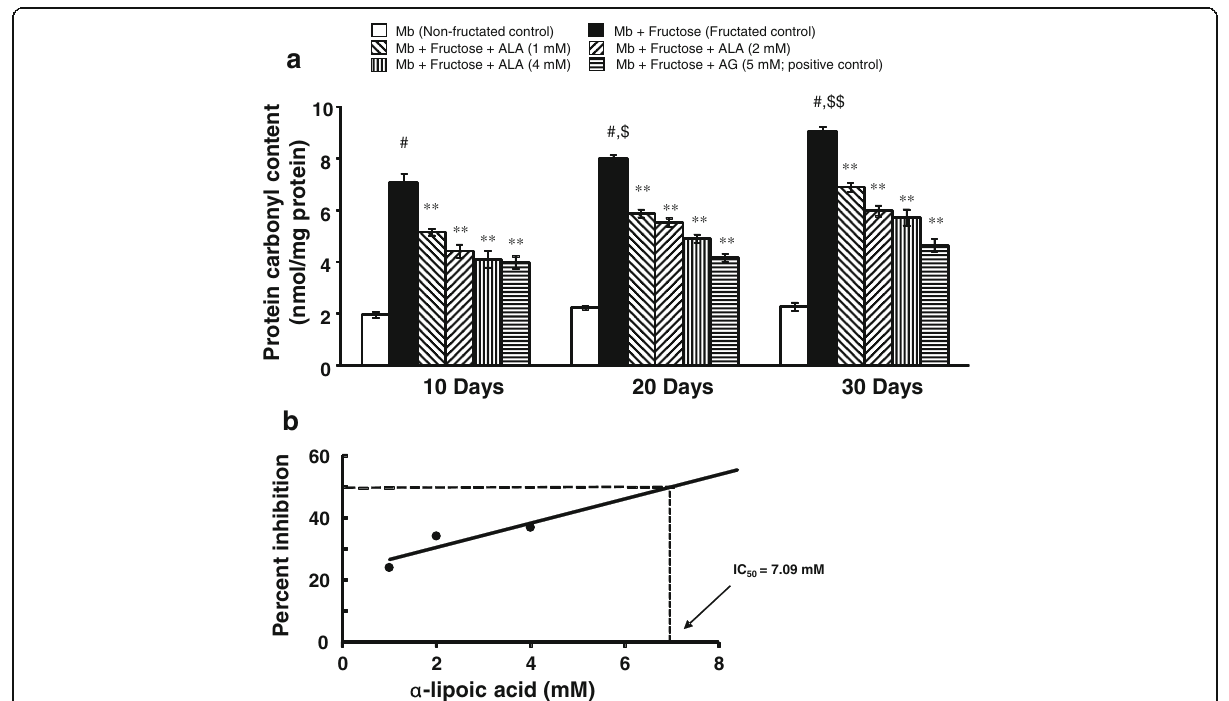
Fig. 4 Effect of α -lipoic acid on protein carbonyl content in fructose-induced myoglobin fructation. Each bar represents the mean ± SEM in six separate experiments ( n = 6). Significant difference compared to fructated control at identical times: * p < 0.05; ** p < 0.01. Significant difference from non-fructated control: # p < 0.001. Significant difference from the respective Day-10 value: $ p < 0.05, $$ p < 0.01. ALA = α -lipoic acid; AG = Aminoguanidine; Mb =